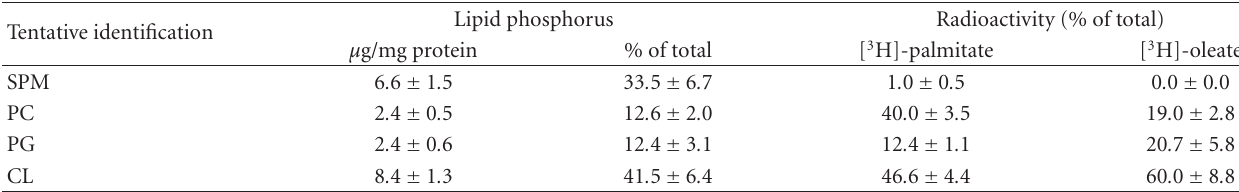
Table 2: The incorporation of radiolabelled fatty acids into the major phospholipids of M.